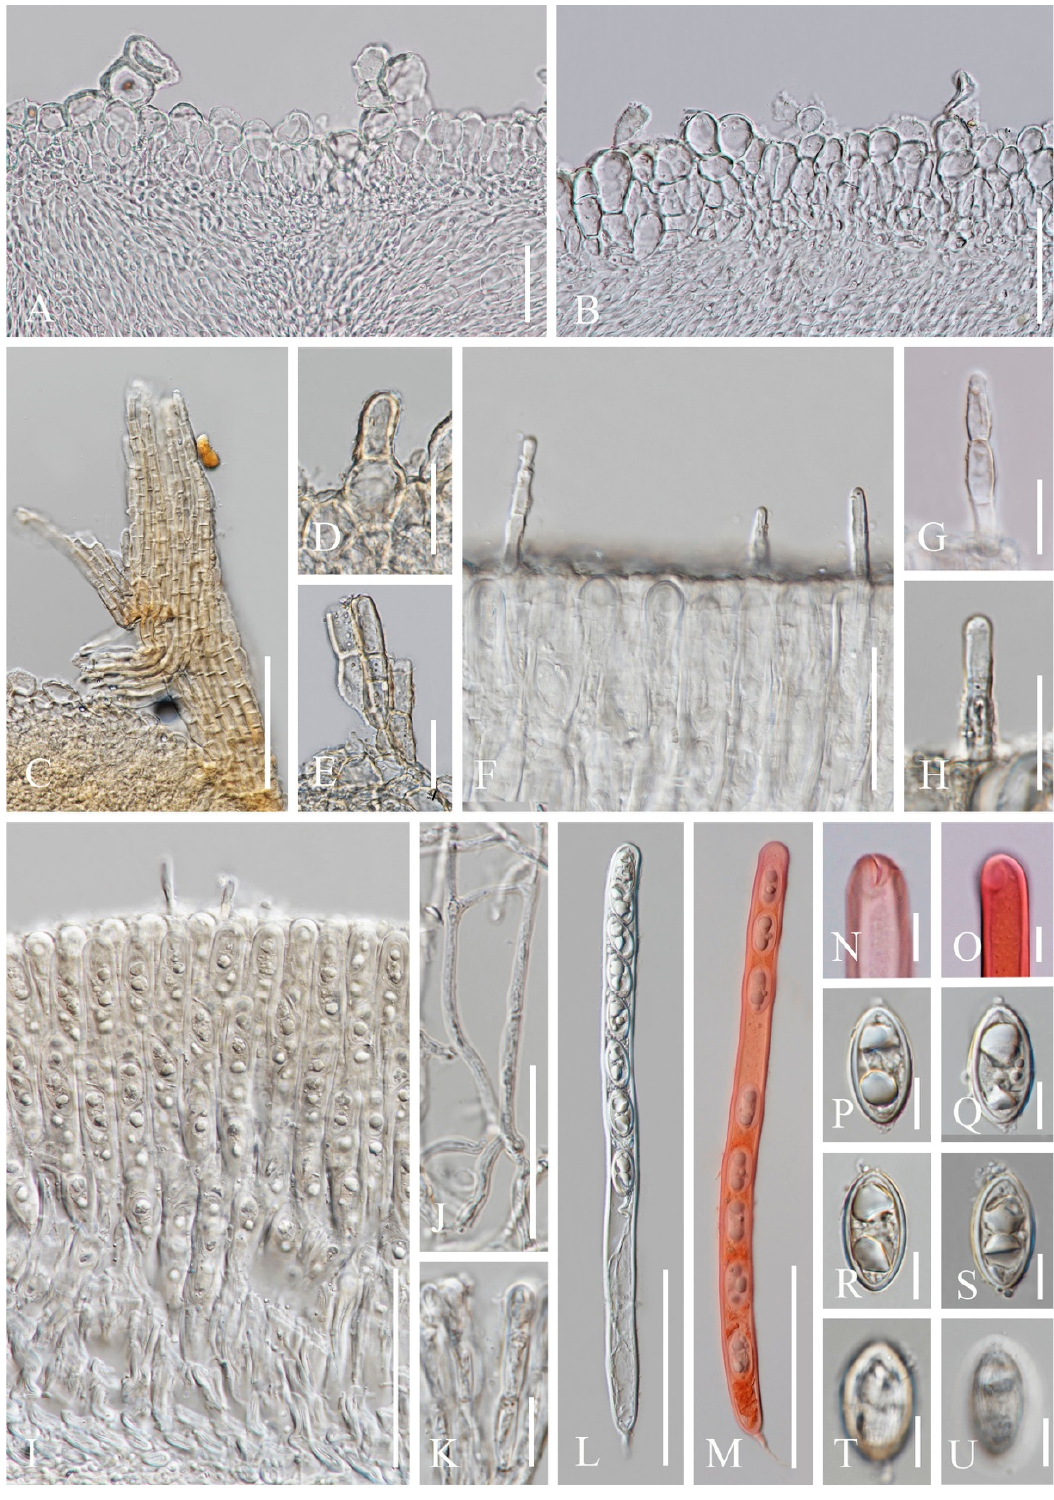
Figure 10. Cookeina speciosa (MFLU 21 ‐ 0162). ( A ) Vertical section of stipe ectal excipulum. ( B ) Vertical section of receptacle ectal excipulum. ( C ) Triangular ‐ shaped compound hair. ( D , E ) Hyphoid hairs. ( F – H ) Hymenial setae. ( I ) Hymenium. ( J ) Paraphyses. ( K ) Apices of the paraphyses. ( L , M ) Asci and ascospores [( M ). Ascus and ascospores in CR.] ( N , O ) Apical part of asci in CR. ( P – U ) Ascospores. Scale bars ( A , B , F ) = 50 μ m; ( C ) = 100 μ m; ( D , E , J ) = 30 μ m; ( G , H ) = 20 μ m; ( K , N – U ) = 10 μ m.